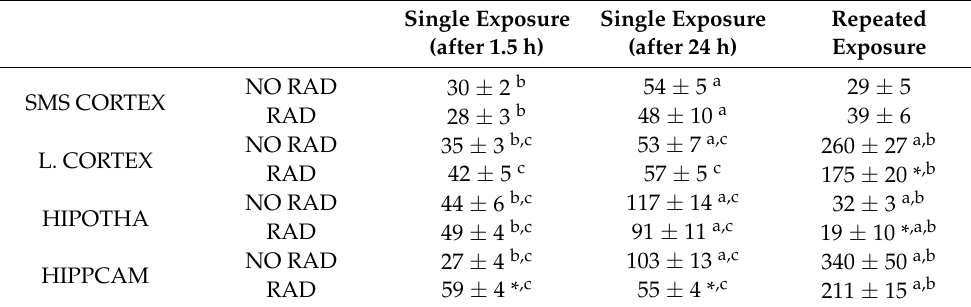
Table 3. Mean values ± SEM of cell counts that were positive for glial fibrillary acidic protein (GFAP) in brain areas: somatosensory cortex (SMS CORTEX), limbic cortex (L. CORTEX), hypothalamus (HIPOTHA) and hippocampus (HIPPCAM), with radiation and without radiation. Single Exposure Single Exposure Repeated (after 1.5 h) (after 24 h) Exposure NO RAD 30 ± 2 b 54 ± 5 a 29 ± 5 SMS CORTEX RAD 28 ± 3 b 48 ± 10 a 39 ± 6 NO RAD 35 ± 3 b,c 53 ± 7 a,c 260 ± 27 a,b L. CORTEX RAD 42 ± 5 c 57 ± 5 c 175 ± 20 * ,b NO RAD 44 ± 6 b,c 117 ± 14 a,c 32 ± 3 a,b HIPOTHA RAD 49 ± 4 b,c 91 ± 11 a,c 19 ± 10 * ,a,b NO RAD 27 ± 4 b,c 103 ± 13 a,c 340 ± 50 a,b HIPPCAM RAD 59 ± 4 * ,c 55 ± 4 * ,c 211 ± 15 a,b Two-way ANOVA (radiation × time) for each area: somatosensory cortex (SMS CORTEX), limbic cortex (L. COR- TEX), hypothalamus (HIPOTHA) and hippocampus (HIPPCAM) ( n = 15 samples/per group). * indicates significant differences between nonirradiated/irradiated animals within each column in each brain area studied. a,b,c indicate significant differences between nonirradiated/irradiated animals within each row in each brain